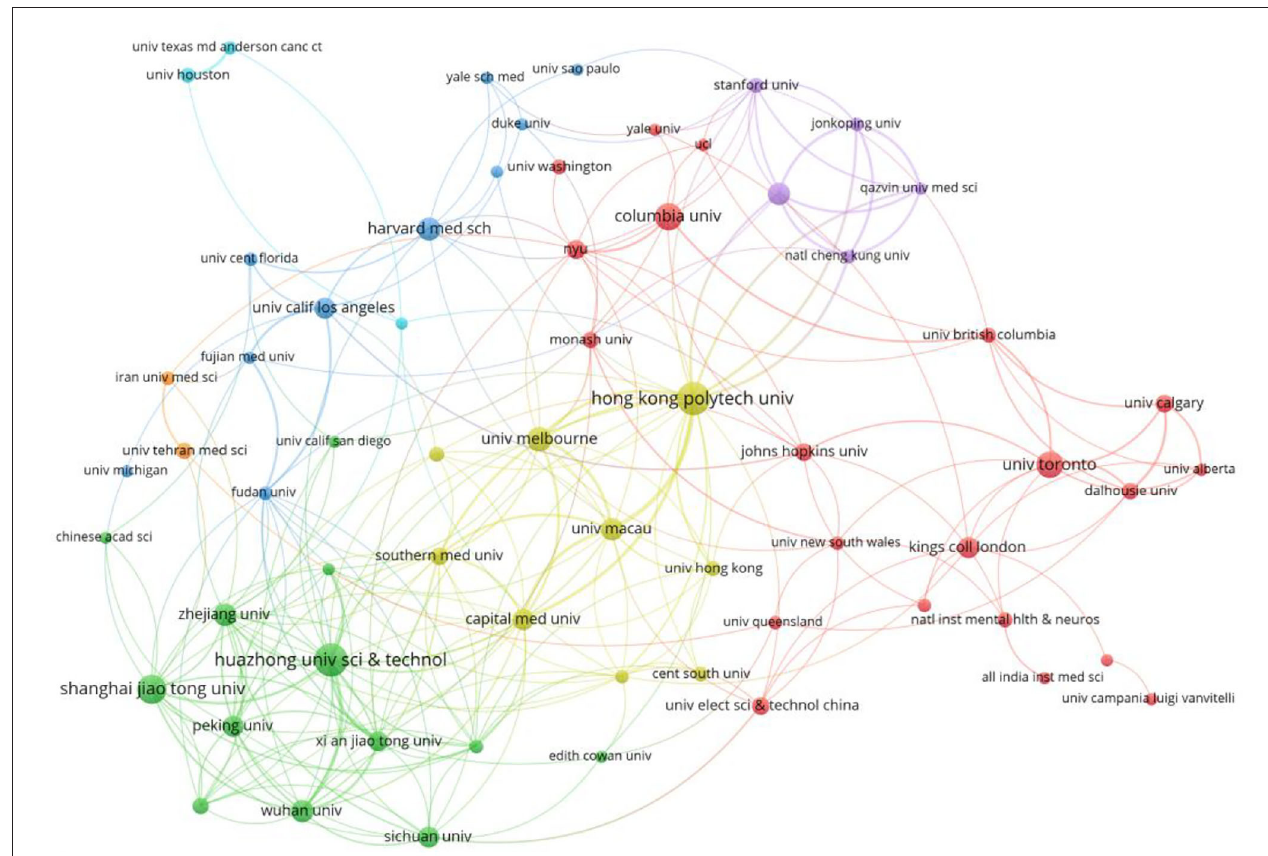
FIGURE 5 | Institutions’